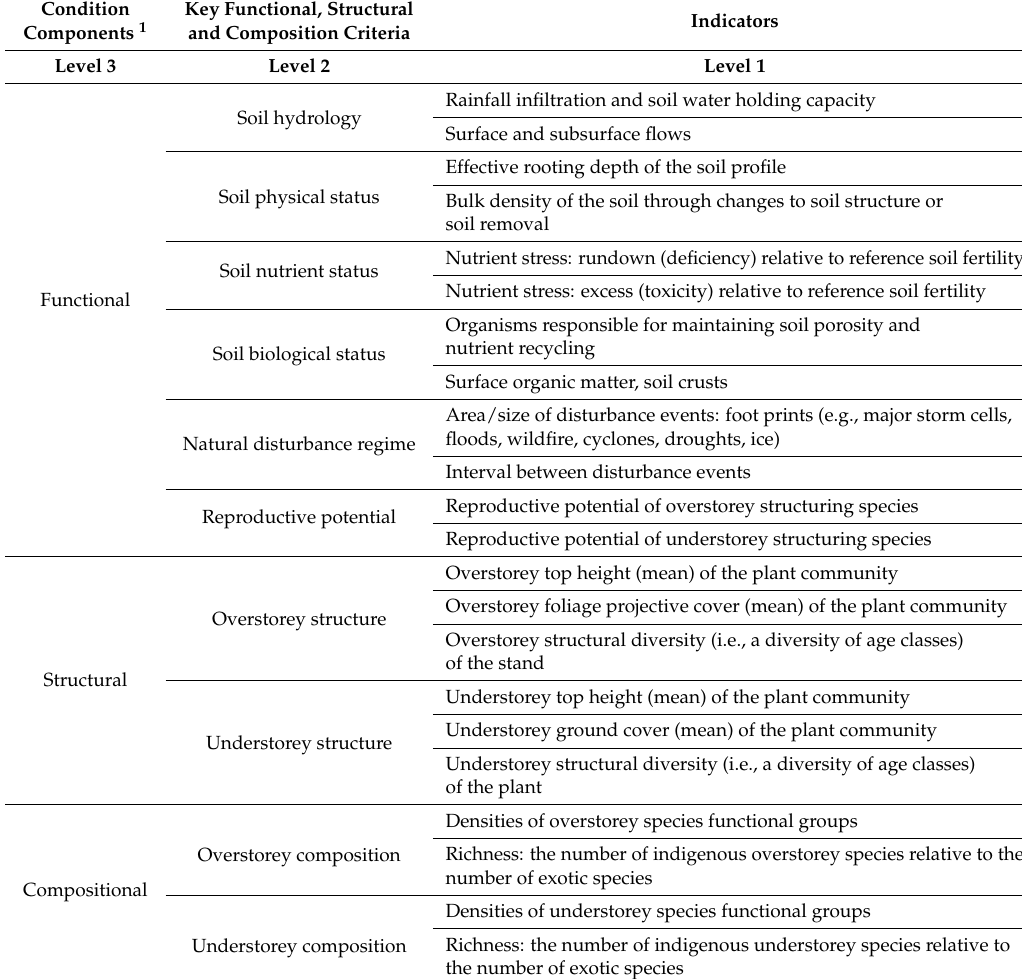
Table 1. List of Vegetation Assets States and Transition (VAST) indicators, criteria and components of vegetation condition [9] used in this paper. Change is assessed relative to an assumed pre-European benchmark. A fourth level results in a vegetation status or transformation index derived by adding the weighted scores from Level 3.